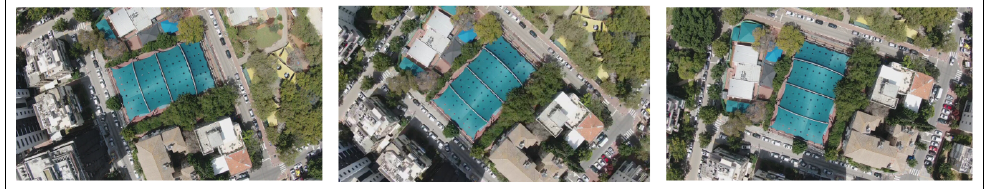
Figure 16. Example of a drone flight in which the drone is changing direction (rotating, rather than flying straight ahead), which causes a false positive due to the decreased correlation between the frames (the frames are presented from left to right ).